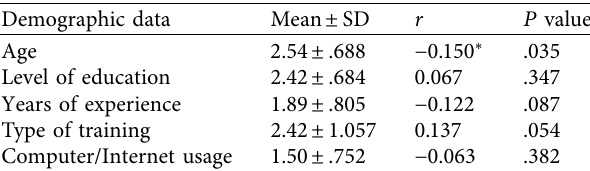
“The bold values provided in this table are the higher number and per- centage of the most and least liked about electronic patient care report system software selected by Table 5: The correlation between demographic data with usability of the ePCR system.